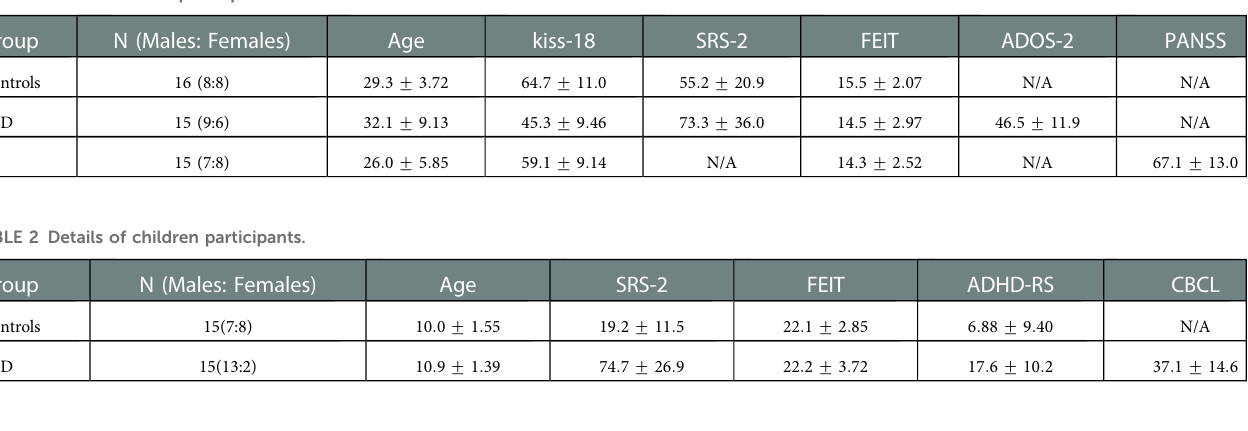
TABLE 1 Details of adult participants.